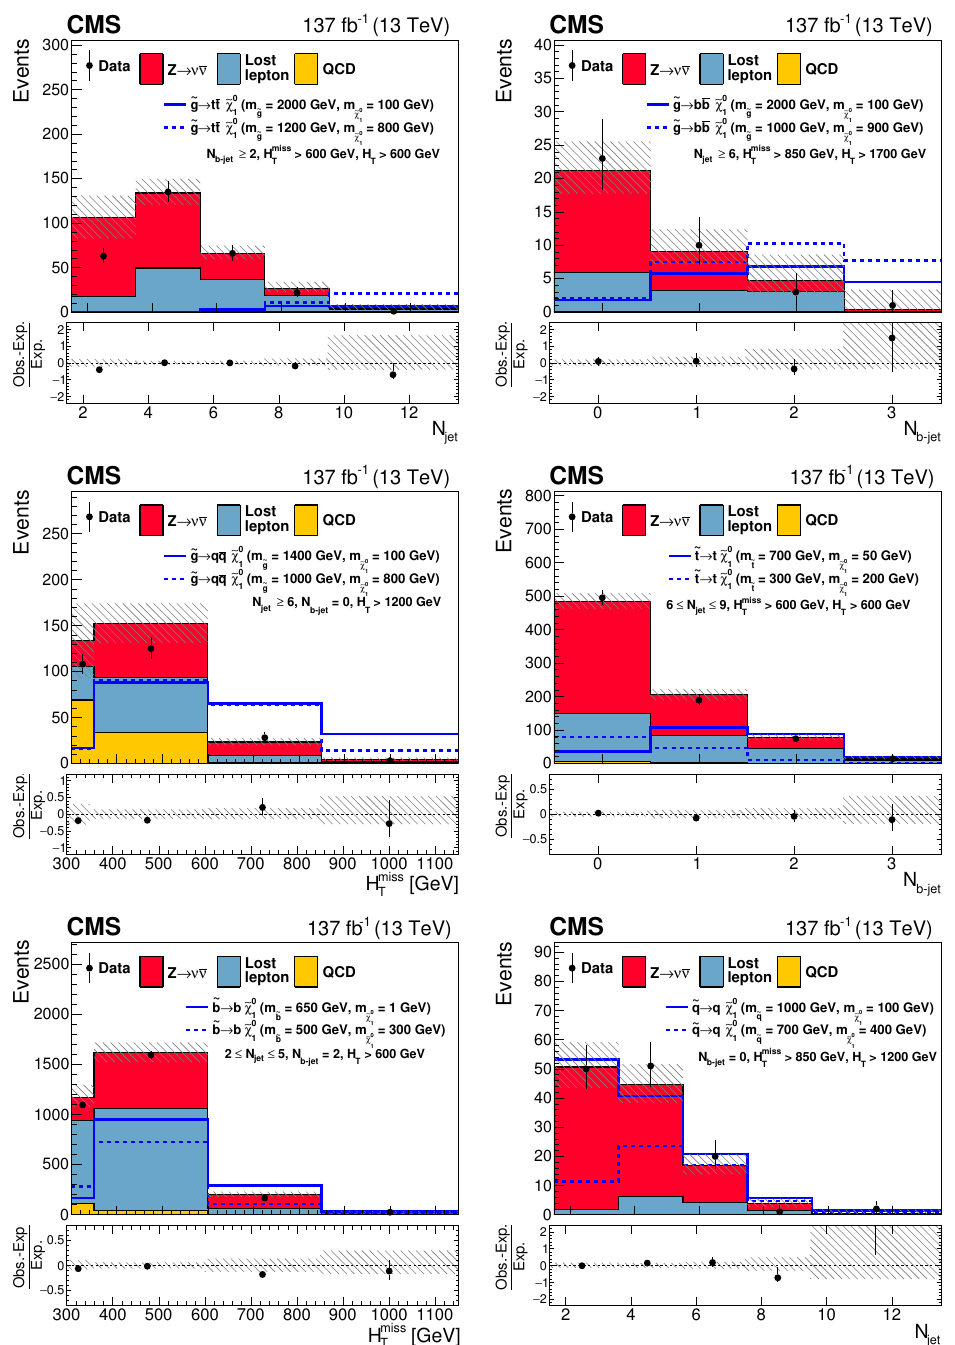
Figure 12 . One-dimensional projections of the data and pre-(cid:12)t SM predictions in either H miss N , or N after applying additional selection criteria, given in the (cid:12)gure legends, to enhance the jet b-jet sensitivity to the (upper left) T1tttt, (upper right) T1bbbb, (middle left) T1qqqq, (middle right) T2tt, (lower left) T2bb, and (lower right) T2qq signal processes. The (unstacked) results for two example signal scenarios are shown in each instance, one with (cid:1) m (cid:29) 0 and the other with (cid:1) m (cid:25) 0, where (cid:1) m is the di(cid:11)erence between the gluino or squark mass and the sum of the masses of the particles into which it decays.